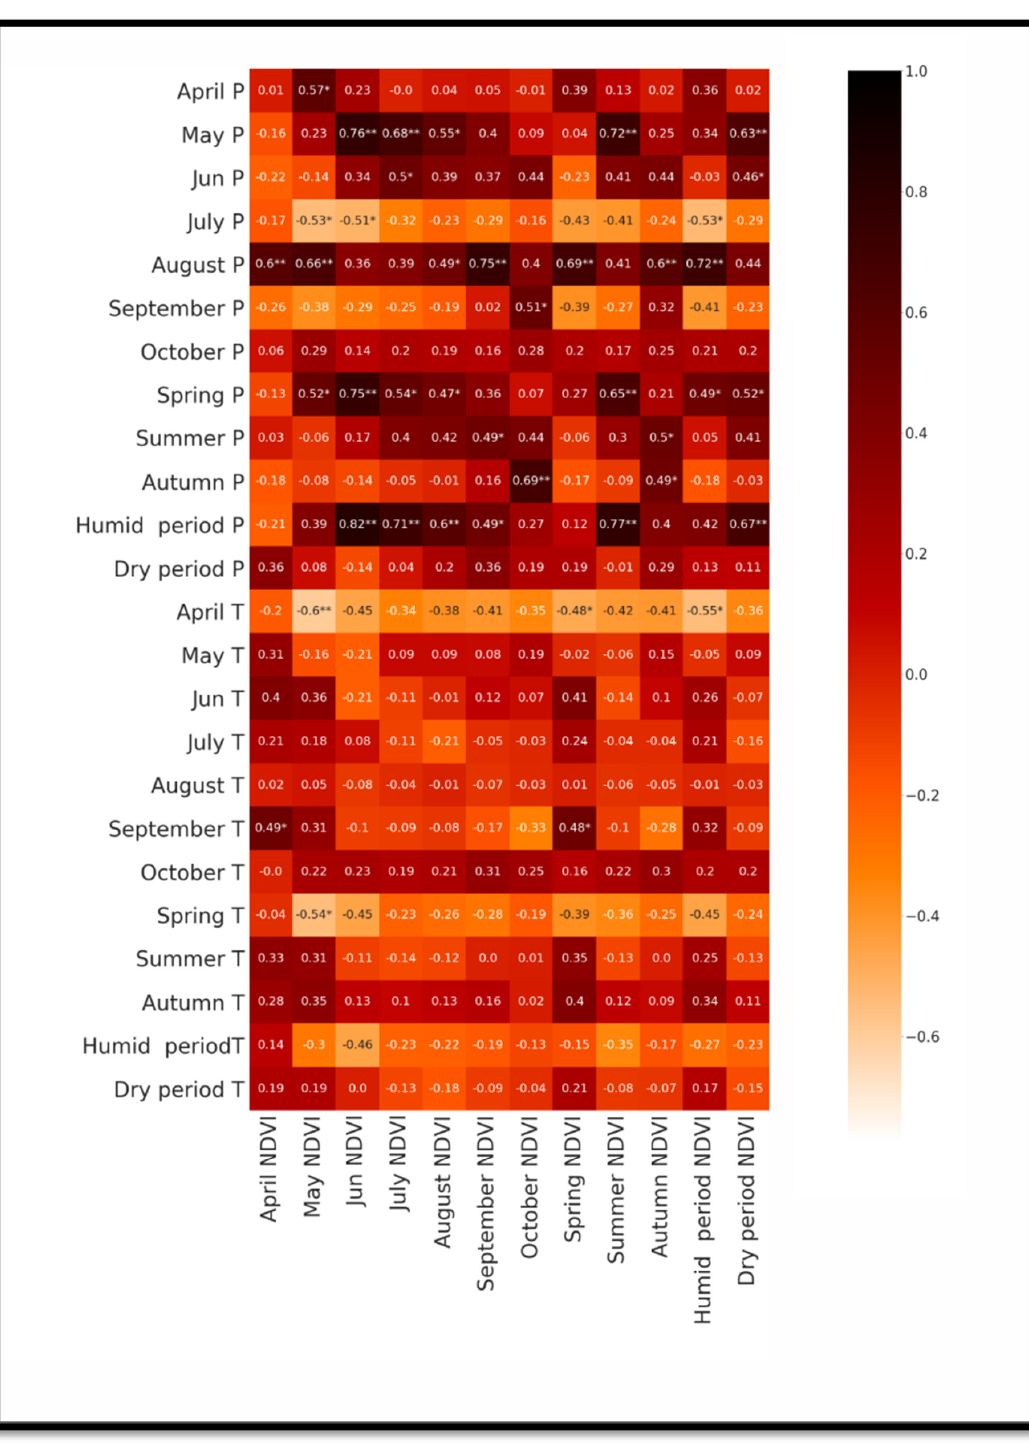
Figure 6. Correlation between temperature, precipitation, and the average monthly, seasonal MODIS NDVI data (with BRDF and topographic, atmospheric correction) for Meghri for the 2000–2018 period, with the levels of significance: *— p < 0.05, ** p <